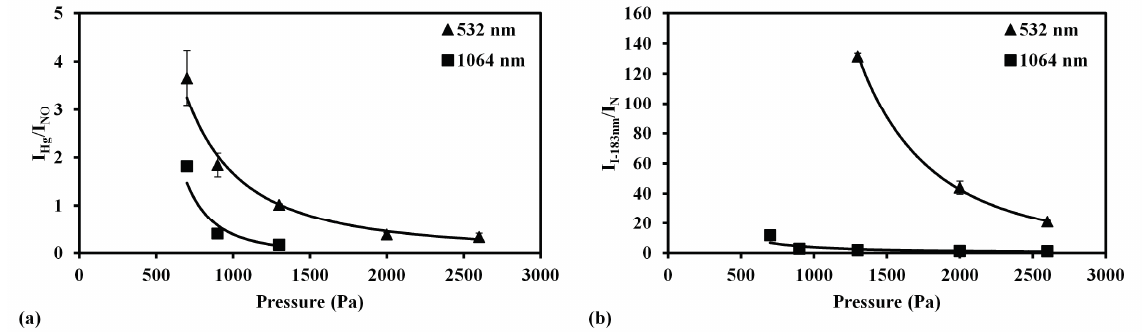
Figure 9. Pressure dependence of signal to noise ratio using 532 nm and 1064 nm laser irradiation in LIBS. ( a ) The ratio of I Hg /I NO . Conditions: ns 532 nm and 1064 nm laser irradiation, delay time 1060 ns, power 400 mJ/p, beam diameter 9 mm, gate width 30 μ s; ( b ) The ratio of I I-183nm /I N . Conditions: ns 532 nm and 1064 nm laser irradiation, delay time 1060 ns, power 400 mJ/p, beam diameter 9 mm, gate width 30 μ